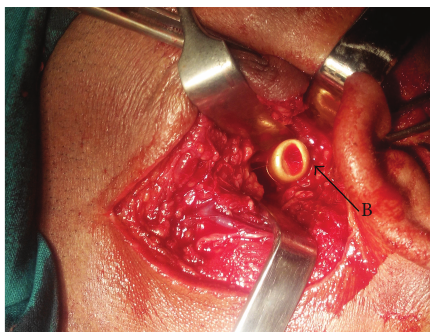
Figure 7: Peroperative photograph, showing the bullet (B) in the left parapharyngeal space after mobilisation of its tip.